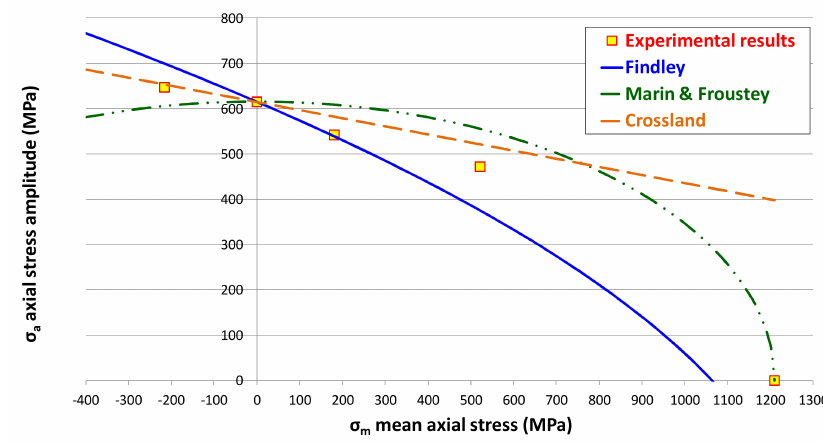
Figure 11. Haigh diagram with the physical lines of Findley [32], Crossland [30], Marin [17] and Froustey [31] and the experimental results at 2 × 10 6 cycles.